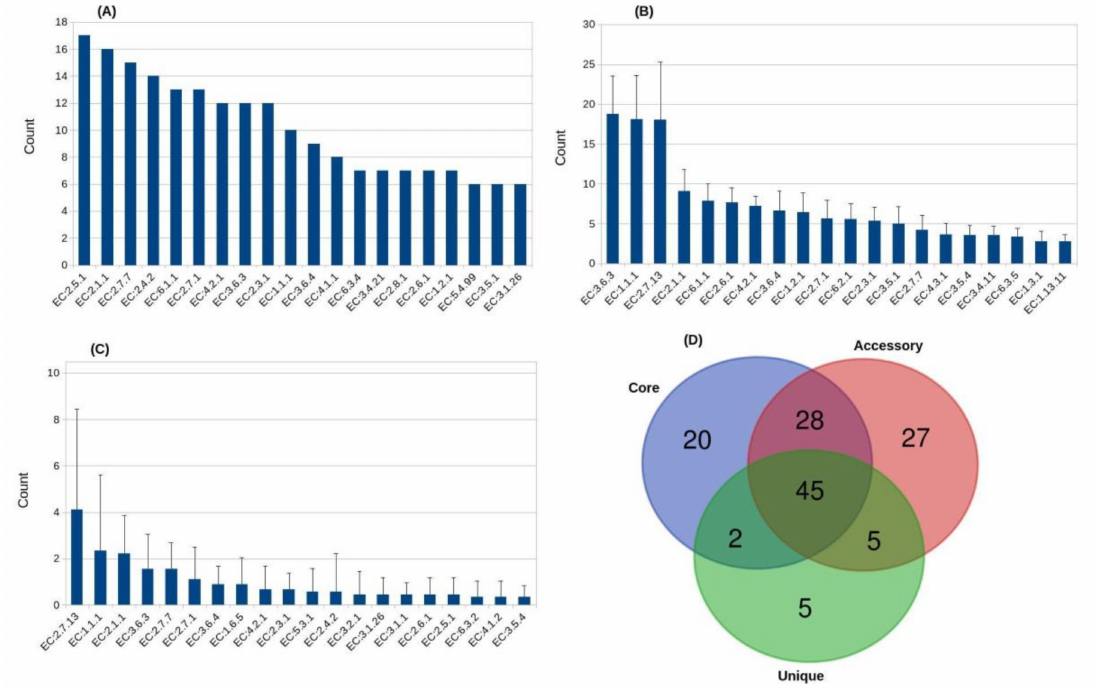
Figure 3. Distribution of the top-most enzyme classification (EC) numbers in the Aneurinibacillus pan-genome; core ( A ), accessory ( B ), and unique ( C ) genomes. Venn diagram showing the number of common and pan-genome-specific EC classes ( D